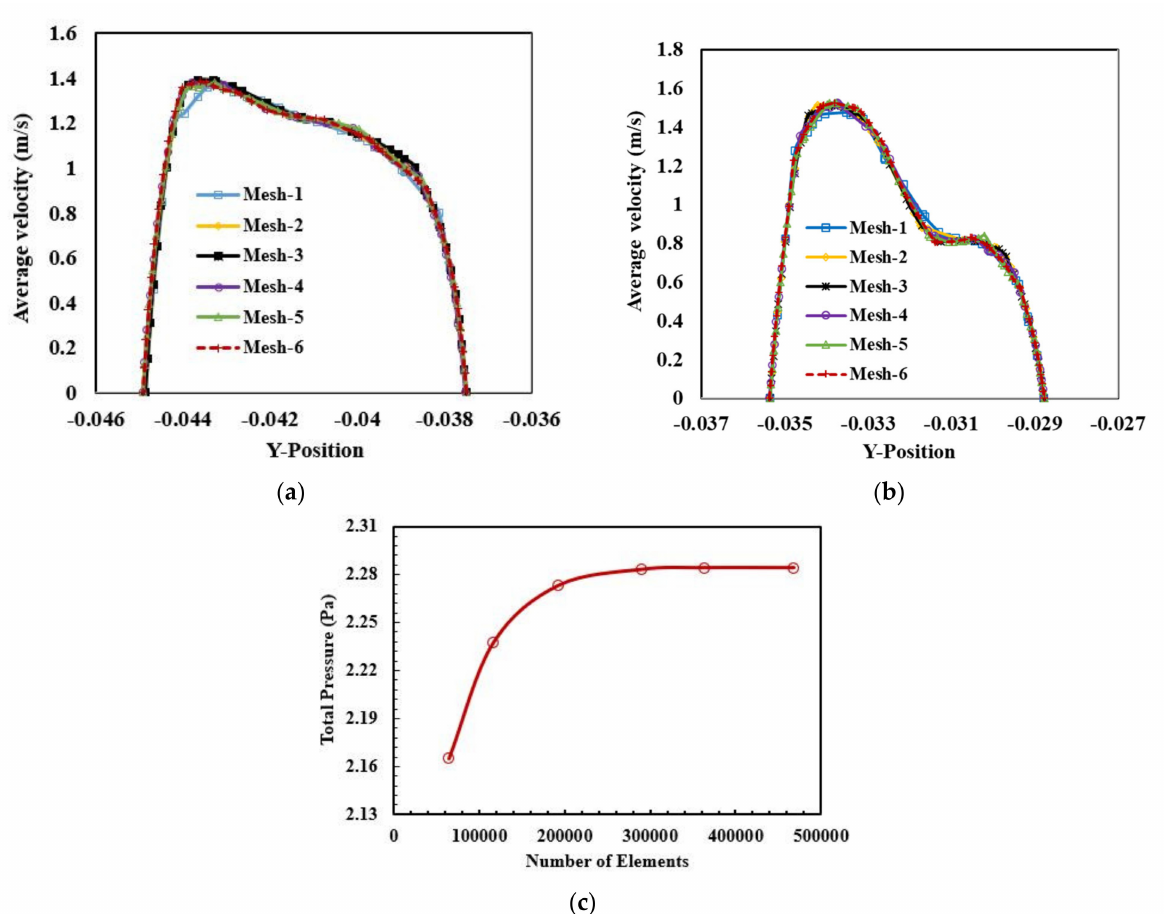
Figure 3. ( a ) Grid refinement/mesh-independent test for ( a ) velocity distribution as functions of grid number (average velocity calculated at the selected line-1 in Figure 1), ( b ) velocity distribution as functions of grid number (average velocity calculated at the selected line-2 in Figure 1), and ( c ) total pressure as functions of grid number at the flow rate 14 L/min (Total pressure calculated at the selected Section-4 in Figure 1) for G0–G3 model for 30 year age.